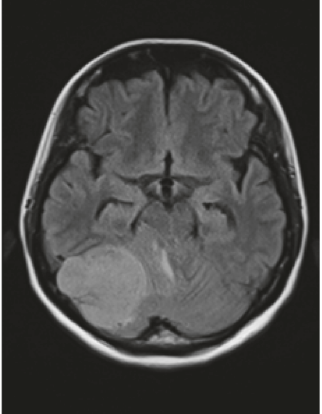
Figure 1: FLAIR MRI of the brain. Compression by the mass toward the brainstem caused deformation.